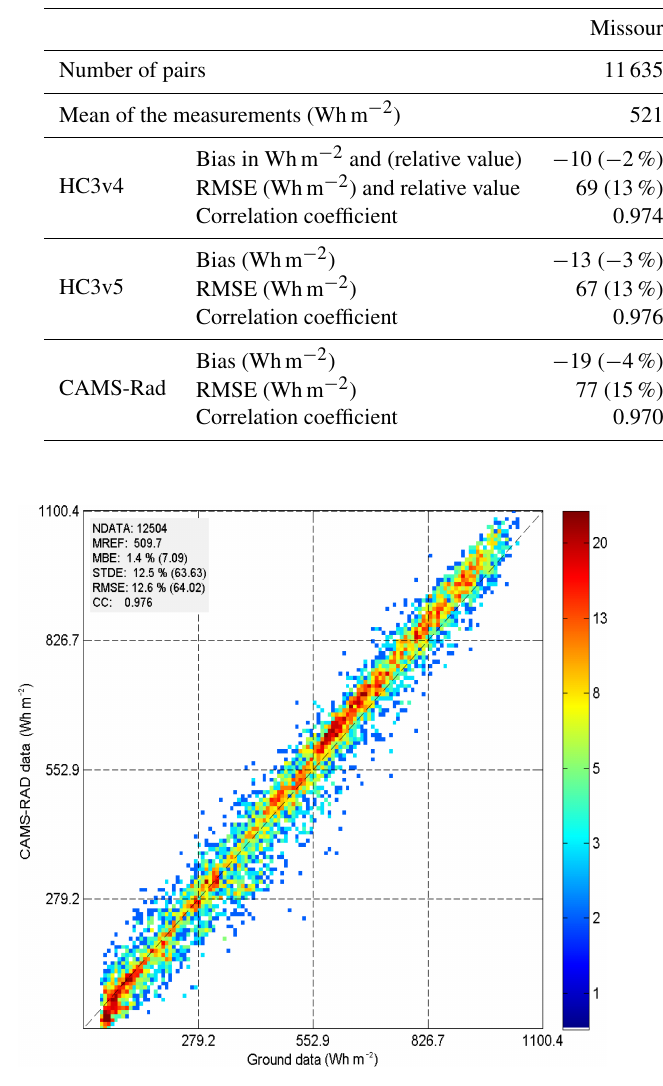
Table 2. Global hourly SSI. Number of coincident data, mean of measurements, bias and RMSE and correlation coefficient for HC3v4, HC4v5 and CAMS-Rad at the five sites. RMSE: root mean square error